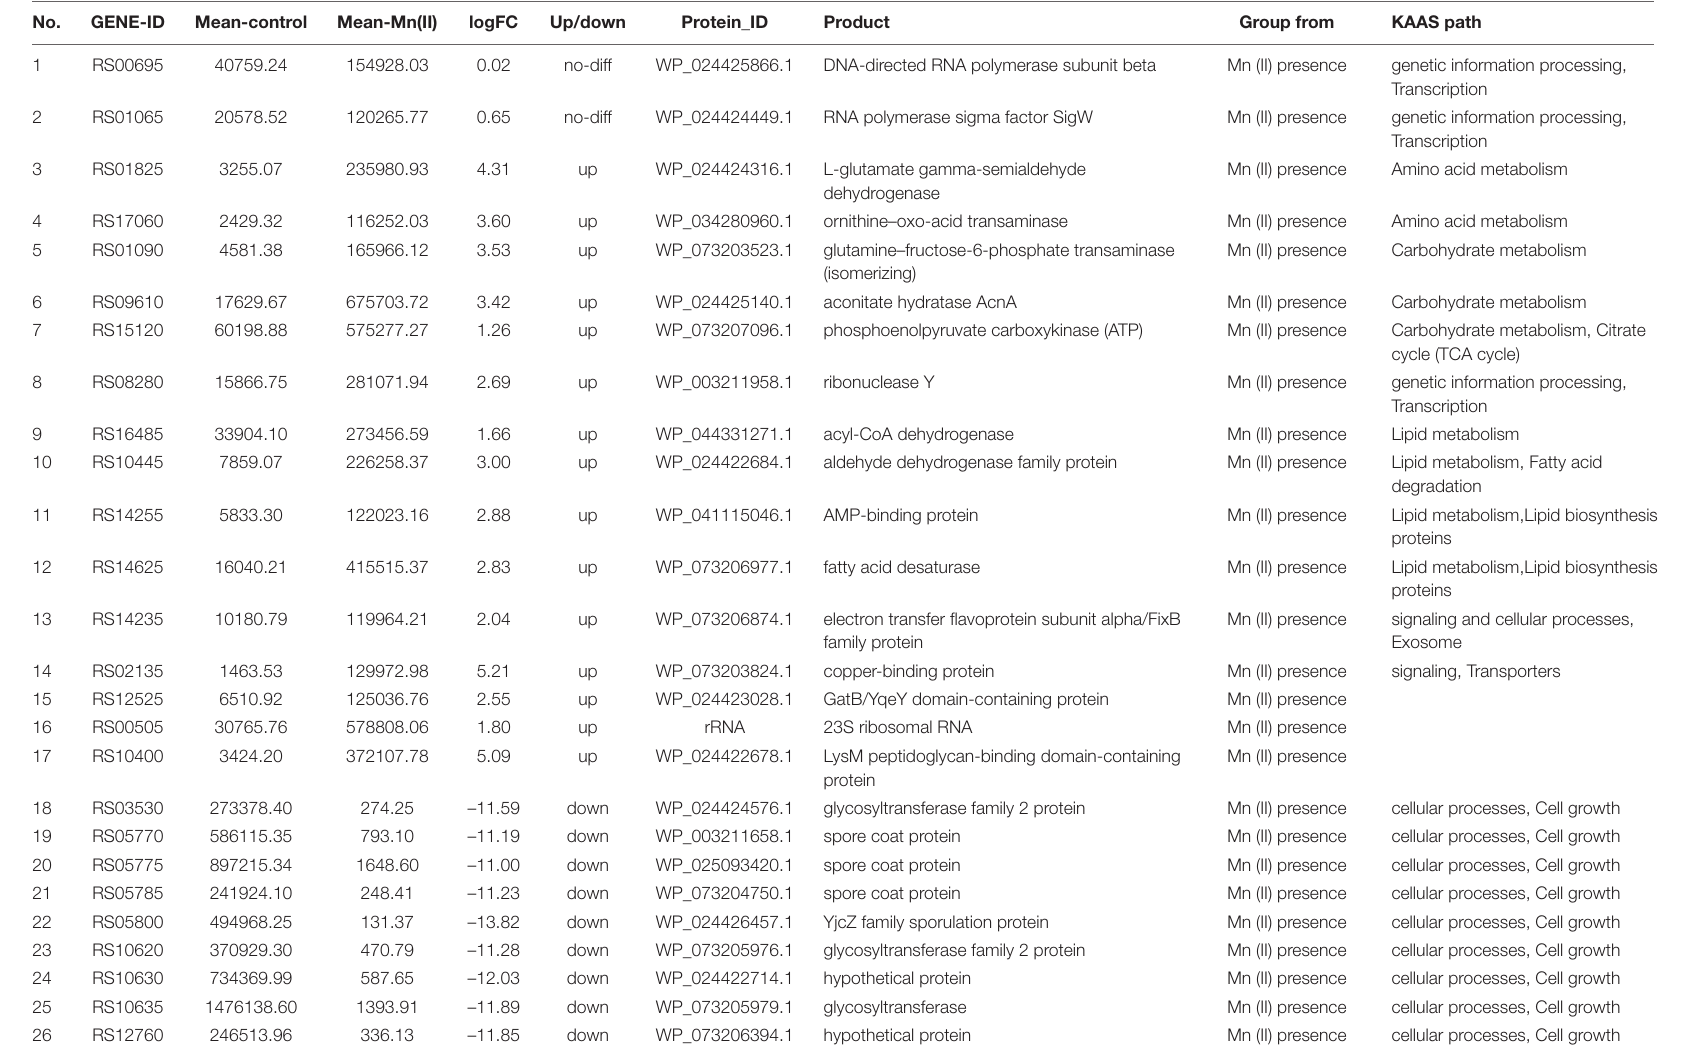
TABLE 3 | Top 20 highly expressed genes in the stationary growth phase of strain ST7.